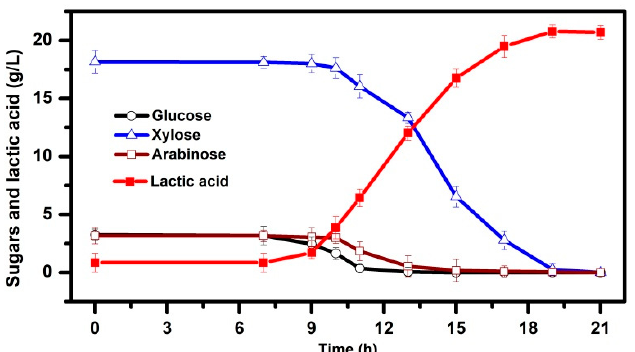
Figure 2. Fermentation of dilute acid hydrolysates of PAS by B. coagulans IPE22. Fermentation was conducted using dilute acid hydrolysates of PAS (glucose, 3.25 g/L; xylose, 18.15 g/L; arabinose, 3.18 g/L) as carbon source. Symbols represent: lactic acid, filled squares; glucose, open circles; xylose, open triangles; arabinose, open squares.